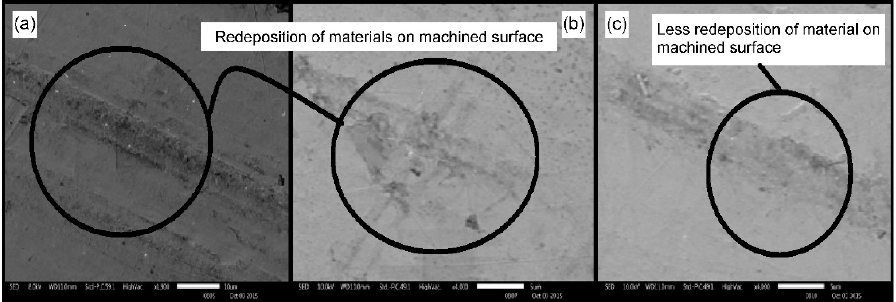
Fig. 8 Machined surface at cutting speed = 250 m/min, feed rate = 0.2 mm/rev, and approach angle = 75°: (a) Al 2 O 3 based nano-fluid,